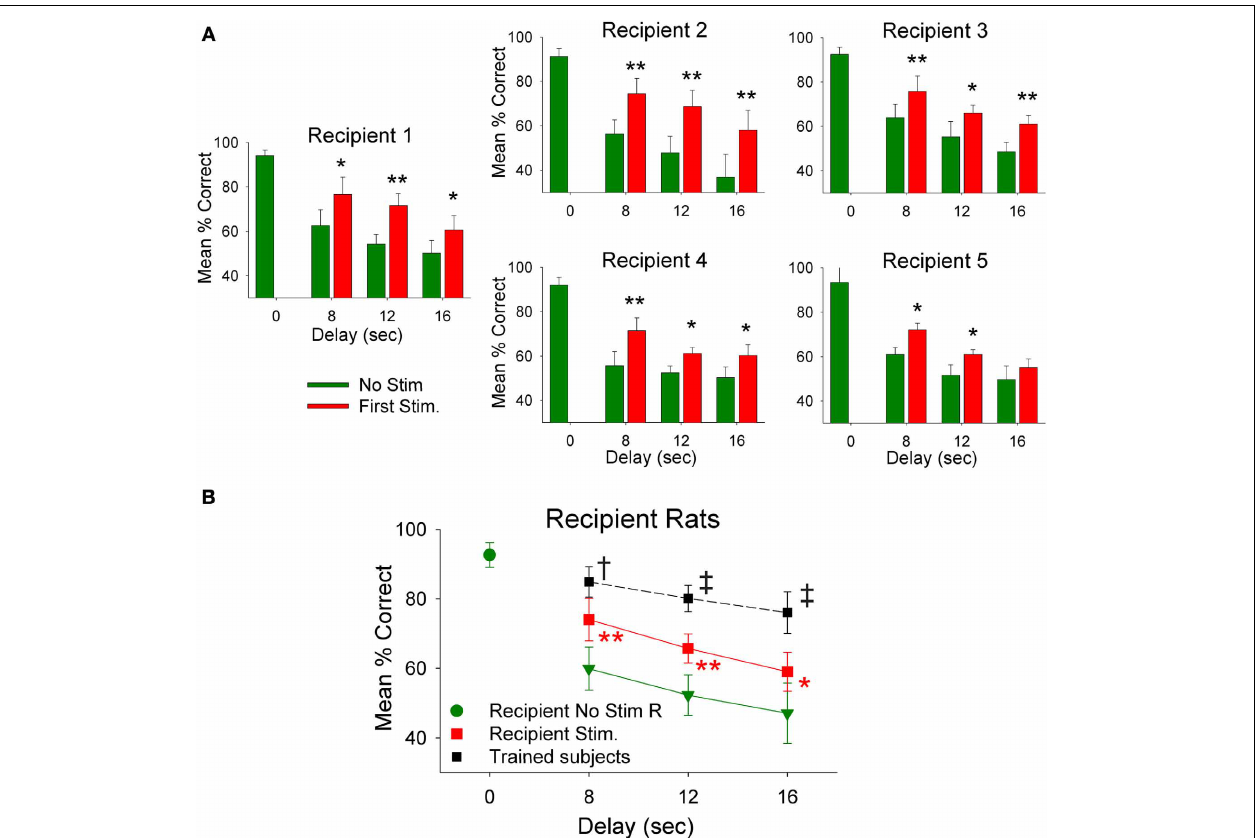
FIGURE 4 | Recipient rat performance on DNMS trials with unfamiliar superimposed delays facilitated by donor rat mediated SR stimulation. (A) Individual DNMS performance of five different recipient rats subjected to trials with 8, 12, and 16s delays shown for trials in which no stimulation was delivered (No Stim) or on trials on which a simultaneously paired donor rat delivery of MIMO SR CA1 stimulation pattern was delivered (Stim). The similarity across each graph indicates generality of facilitated performance on imposed delay trials with delivery of donor rat MIMO generated CA1 SR stimulation. Asterisks ∗ p < 0 . 01, ∗∗ p < 0 . 001, Stim donor rat vs. No Stim. (B) Overall performance